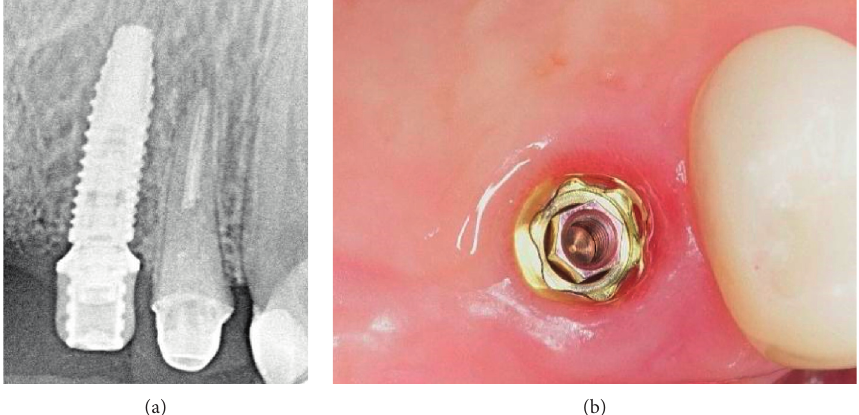
Figure 20: (a) Bone formation under the On1 base (8 weeks). (b) Condition of the soft tissues around the On1 base (8